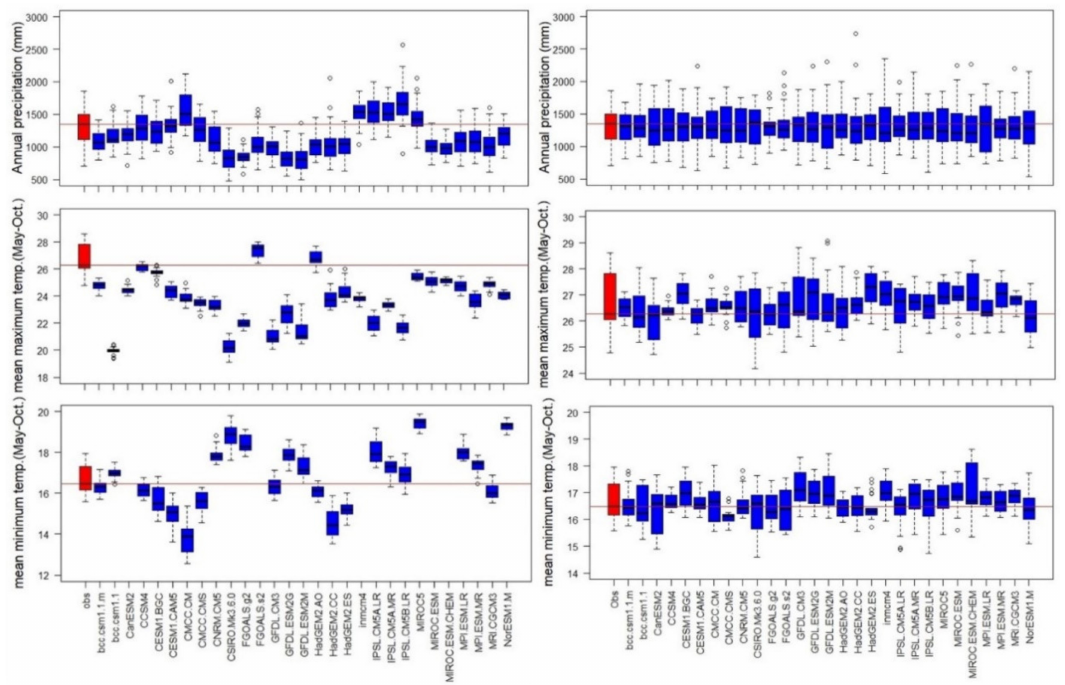
Figure 4. Comparison of raw ( left ) and bias-corrected ( right ) reproducibility with observed data for Jeonju stations in terms of the annual precipitation, mean maximum temp. (June-September), and mean minimum temp.